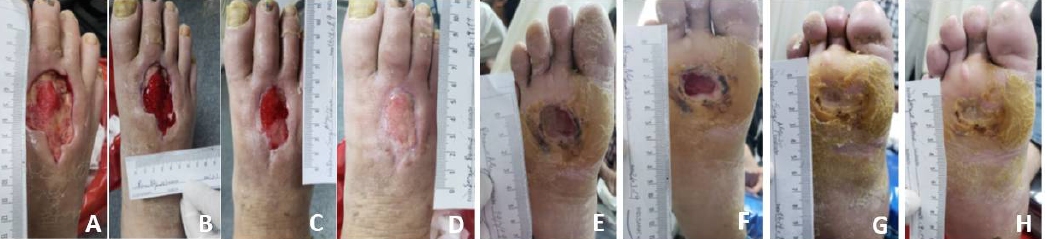
Figure 1. A 60-year-old male with DFU of 3 months duration on dorsal foot before application of SuDe + Lp ( A ); DFU treated with daily SuDe + Lp from day 1 to day 42 ( B – D ). A 58-year-old male with DFU of 3 months duration on plantar surface foot before application of SuDe + Lp ( E ) and daily application of SuDe + Lp from day 1 to day 35 ( F – H ).